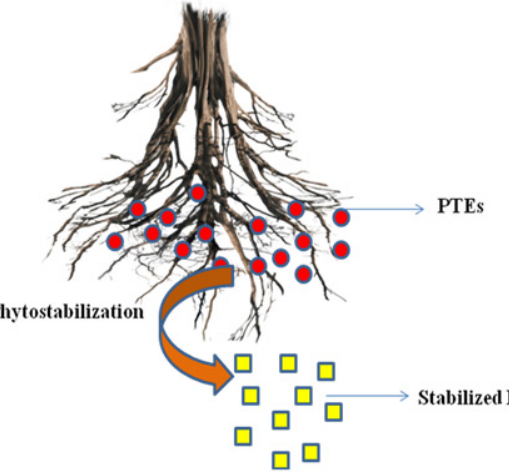
Figure 6. Major mechanisms underlying phytostabilization.